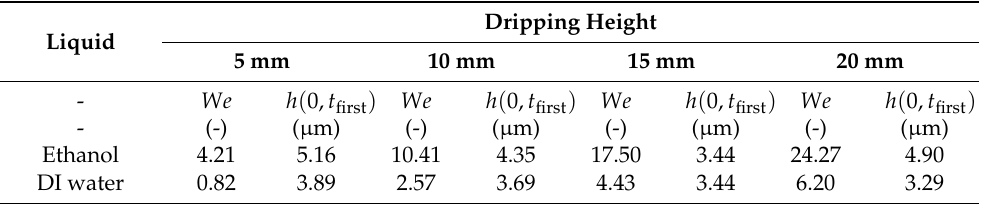
Table 3. Dimple formation heights for ethanol and DI water in the absent of an electric field.